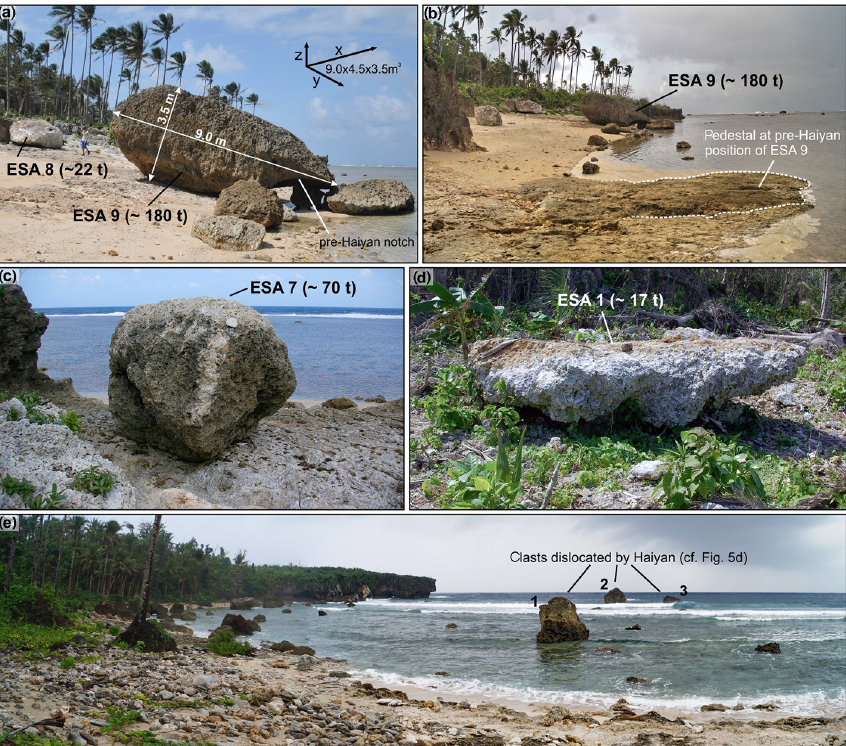
Figure 5. Photos of largest Haiyan-transported clasts at ESA. (a) Photo of ESA 9, the largest clast found at site ESA. (b) A ∼ 5cm high pedestal (foreground) was found at the pre-Haiyan position of ESA 9 (background). (c) Photo of ESA 7 looking from the SW towards the lagoon. (d) Boulder ESA 1, situated at ∼ 10m MLLW, directly below the run-up limit. (e) Panorama photo of Nagaha Bay (March 2015); view is to the SSE. Clasts 1–3 were dislocated by Haiyan, as documented by post-Haiyan satellite images (cf. Fig.